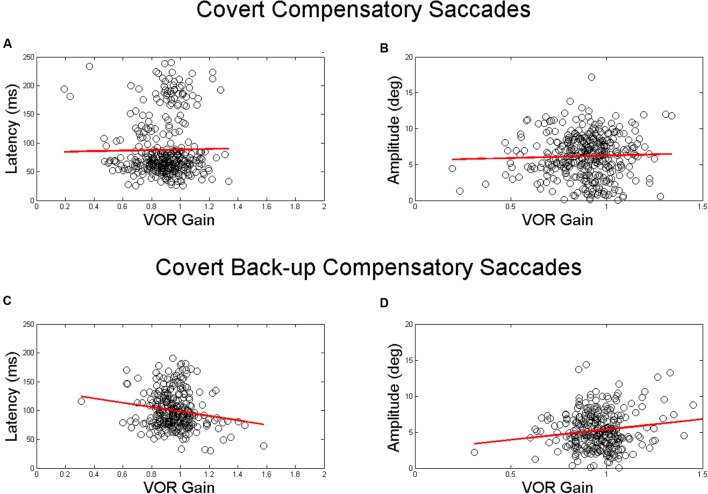
Relationship between VOR gain and first covert saccades. Relationship between VOR gain and covert saccade latency (A,C) and covert saccade amplitude (B,D). The top plots demonstrate the relationship for compensatory saccades, while the lower plots show the relationship for back-up saccades. The red line in each plot indicates the linear best fit for the relationship. Each point represents a single HIT.